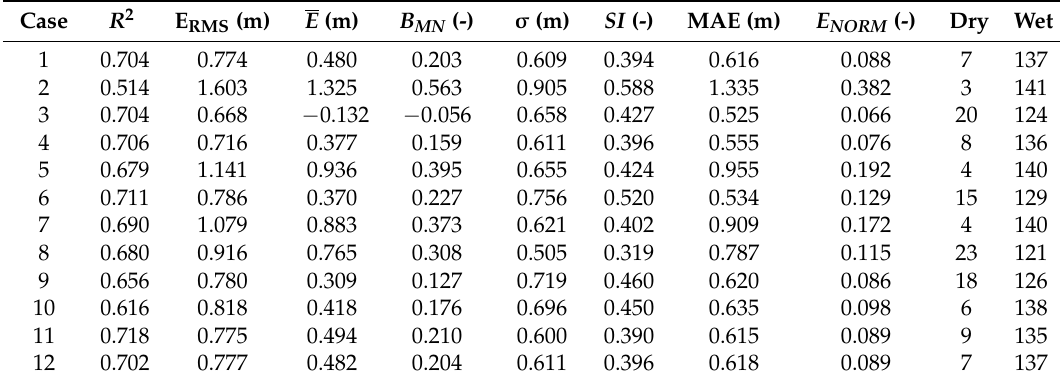
Figure 7. Scatter plots of Rita HWM’s. Red, yellow, and light green points indicate over-prediction by the model; blue, dark blue and purple points indicate underprediction. Green points indicate a match within 0.5 m. The black line represents the best fit lines. ( a ) Case 1; ( b ) Case 2. Table 3. Rita Simulations HWM Error Table 3. Rita Simulations HWM Error Statistics.